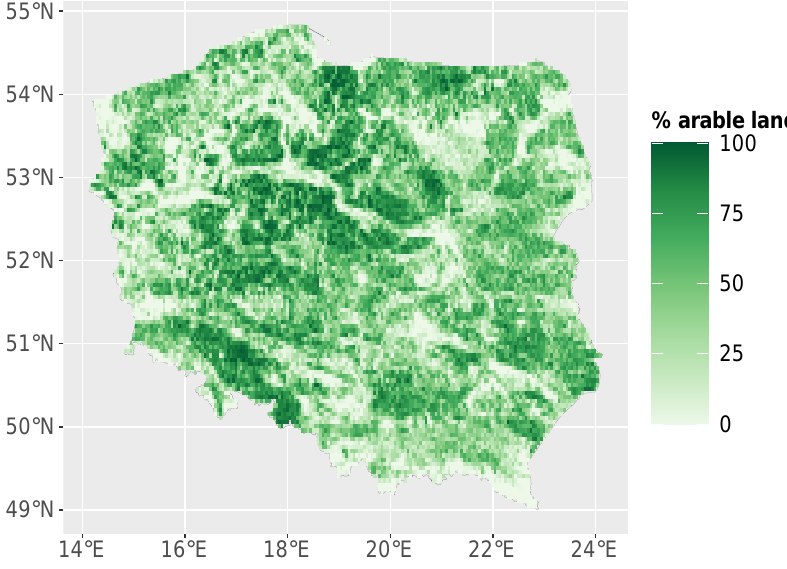
Figure 1. Fractional arable land [%] in